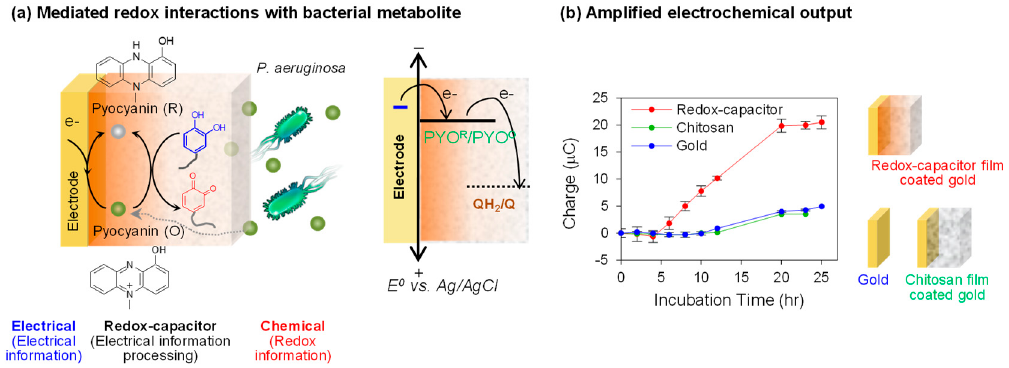
Figure 7. Electrochemical detection of the redox-active bacterial metabolite pyocyanin (PYO). ( a ) Schematic shows that the redox-capacitor can amplify the reduction current of PYO due to the reductive redox-cycling reaction. QH 2 /Q: Catechol(QH 2 ) moieties/quinone (Q) moieties of catechol–chitosan film. ( b ) Compared with bare gold and chitosan-coated electrode, the redox-capacitor can sensitively detect the PYO production by bacteria. Adapted with permission from [50]. Copyright (2013) American Chemical Society.